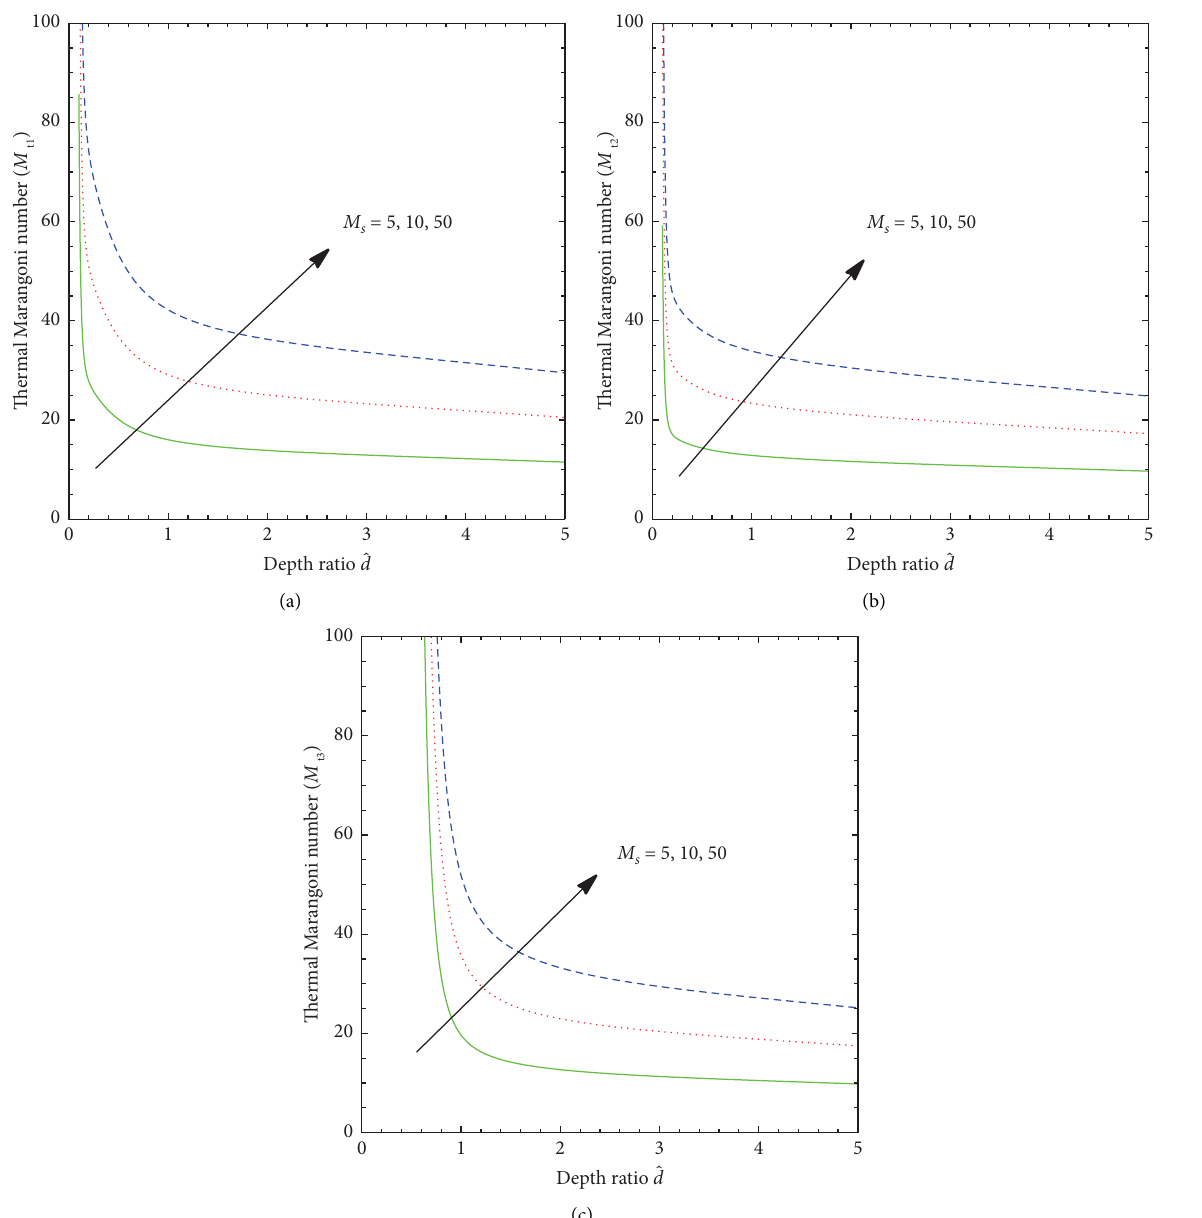
Figure 5: Te infuence of the solute Marangoni number M τ p � 0 . 5, R ∗ If � R ∗ Ip �